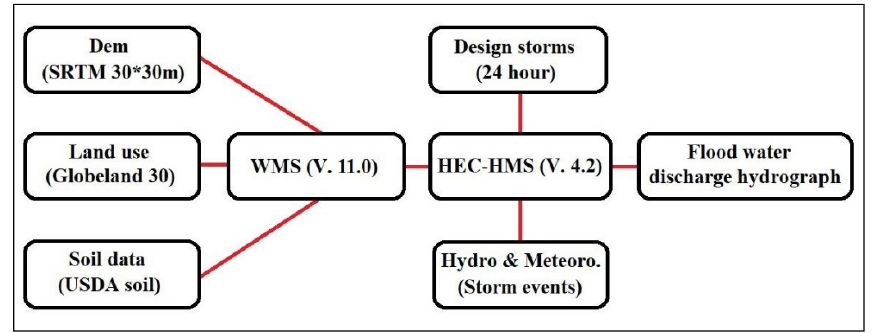
Figure 2. Flowchart for HEC-HMS methodology.